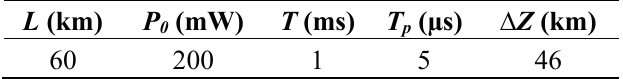
Table 1. Parameter